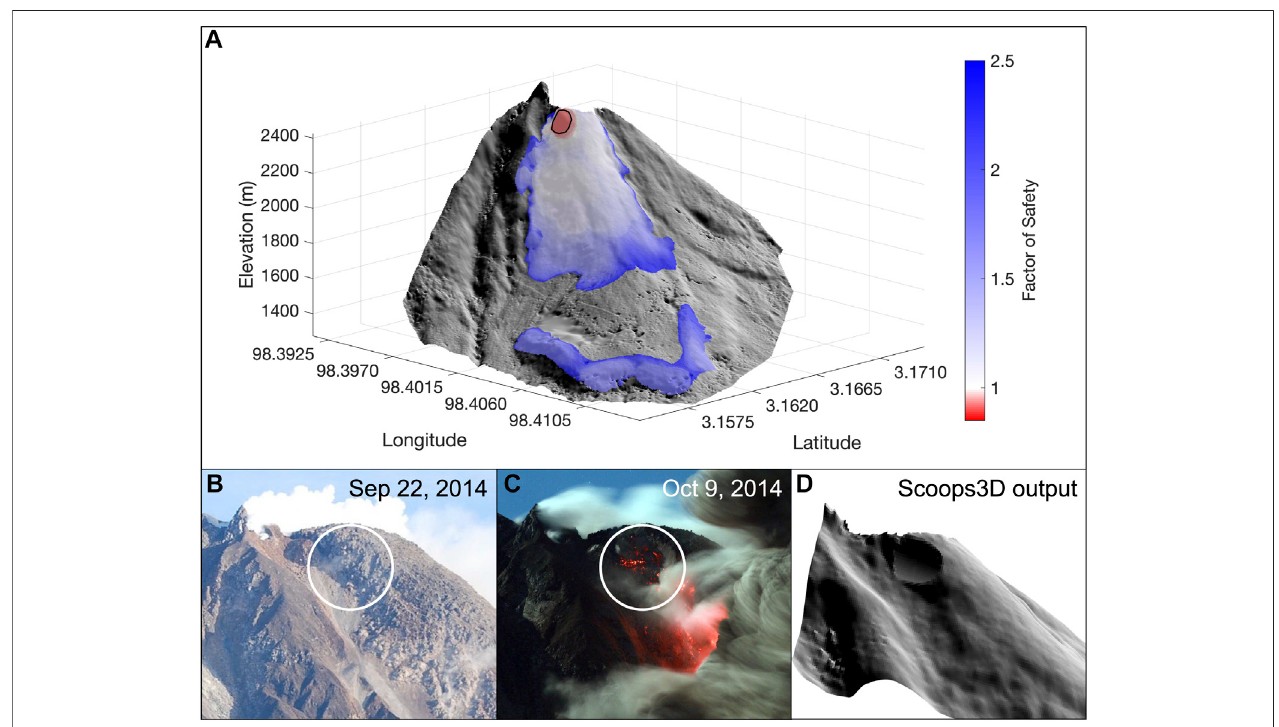
FIGURE 7 | Slope stability analysis results for the 2014 topography (maximum collapse volume = 0.3 × 10 6 m 3 ). Limiting the collapse volume in Scoops3D to a range approximating the size of the initial October 2014 passive collapse and assuming ʻ weaker lava ’ properties, reproduces the location and appearance of the observed collapse: (A) All unstable surfaces identi fi ed by Scoops3D ( FOS < 1, red shades) are located where the October collapse occurred, and the FOS min collapse size (black outline, a) is similar. (B,C) Visual images show the region of the collapse (white circle) before and after the event. The 3D perspective of the collapse producedbyScoops3D (D) showsthesimilarityofthemodeledtoobservedcollapse.Photocredits:L.Vanderkluysen (B) ;DediSahputra/EPA/Shutterstock (C) ; (B) and (C) modi fi ed from Carr et al. (2019b).